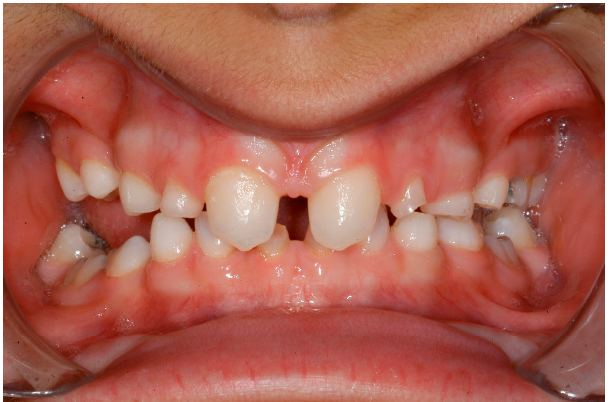
Figure 5. Intraoral situation: oligodontia, microdontia of teeth 11 and 21 and a pronounced lateral open bite.